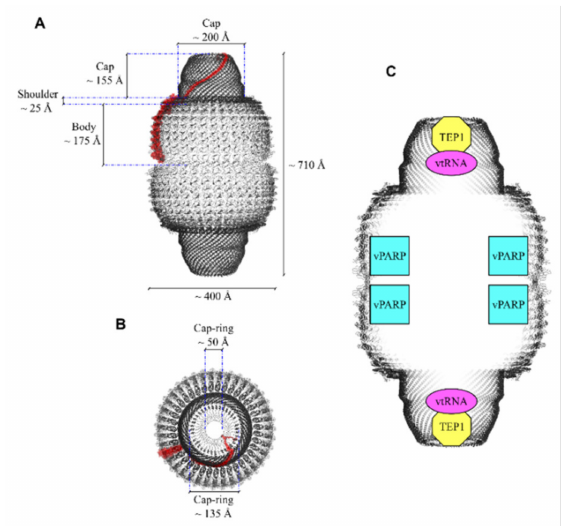
Figure 1. Structural features of the vault nanoparticle. ( A ) Side view, where a single major vault protein (MVP) molecule is colored in red. ( B ) Top view. ( C ) Cross-section including a schematic representation and location of the minor vault molecular